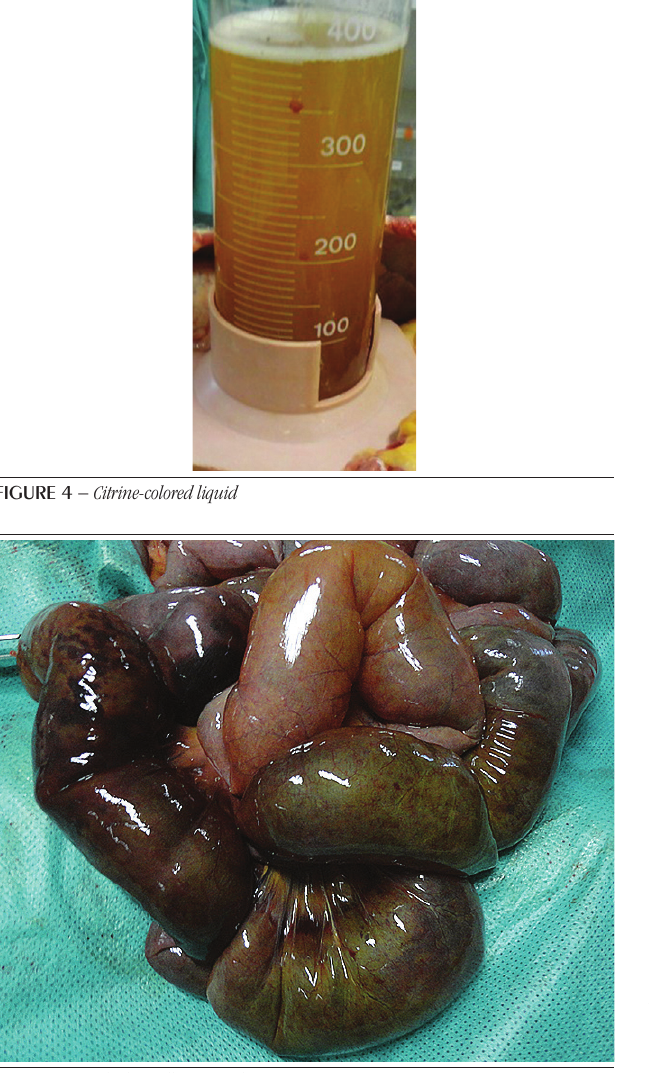
figurE 5 − Black small intestine loops